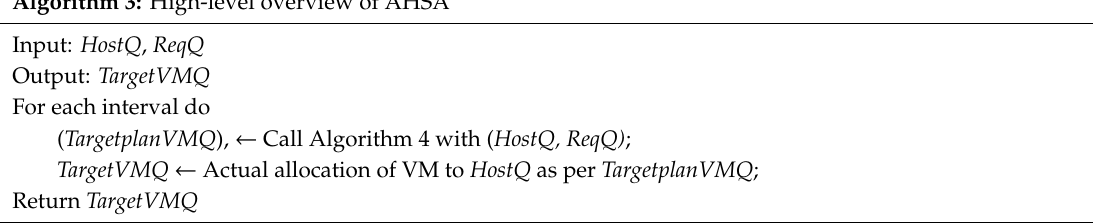
Algorithm 3: High-level overview of